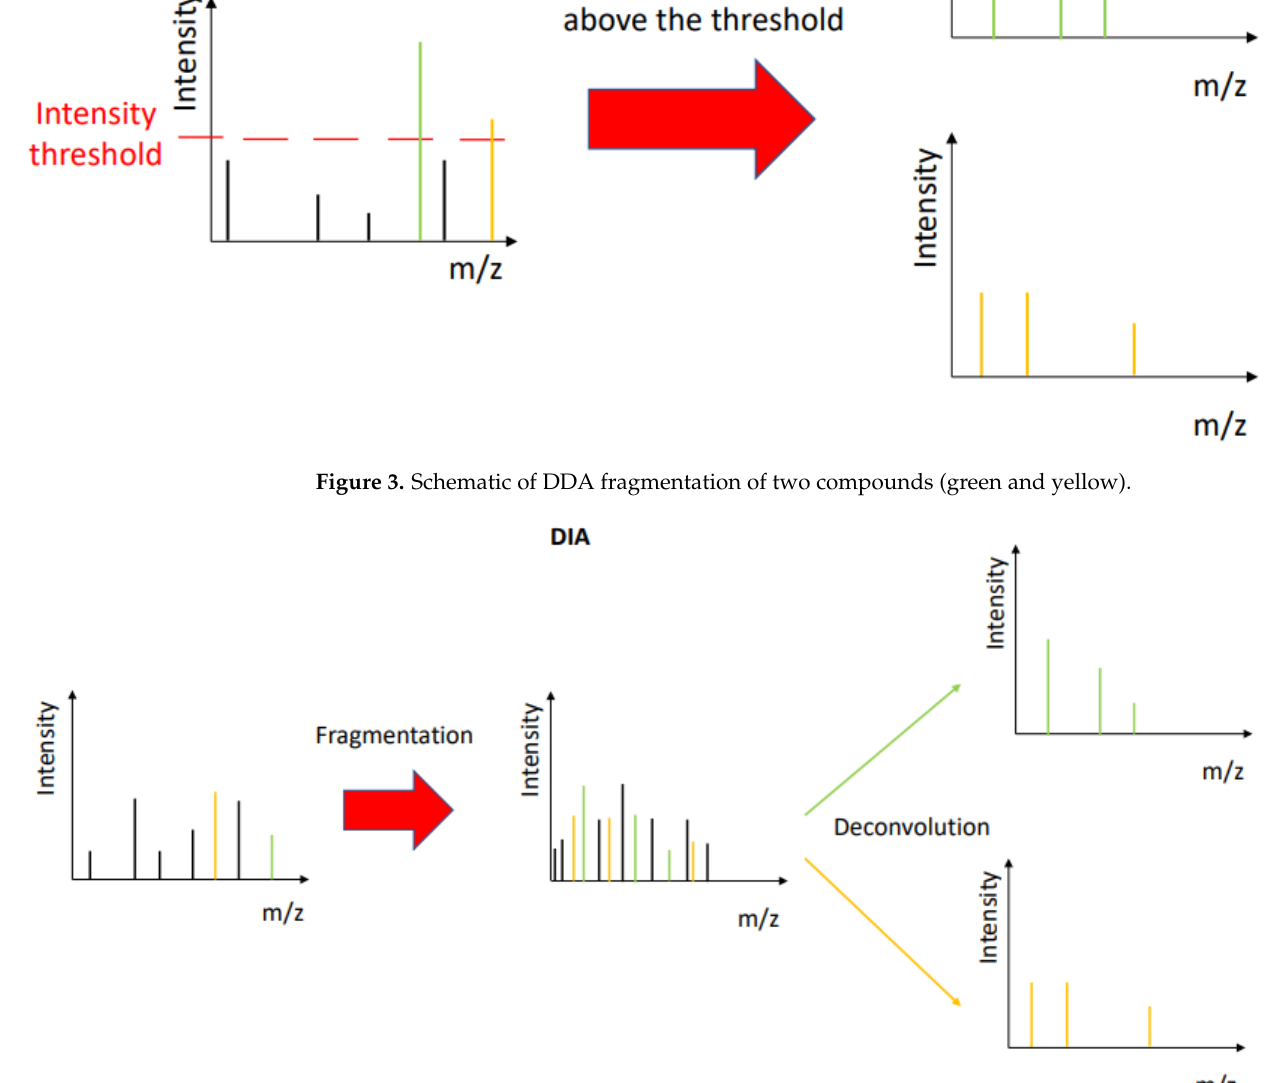
Figure 4. Schematic of DIA fragmentation of two compounds (green and yellow).